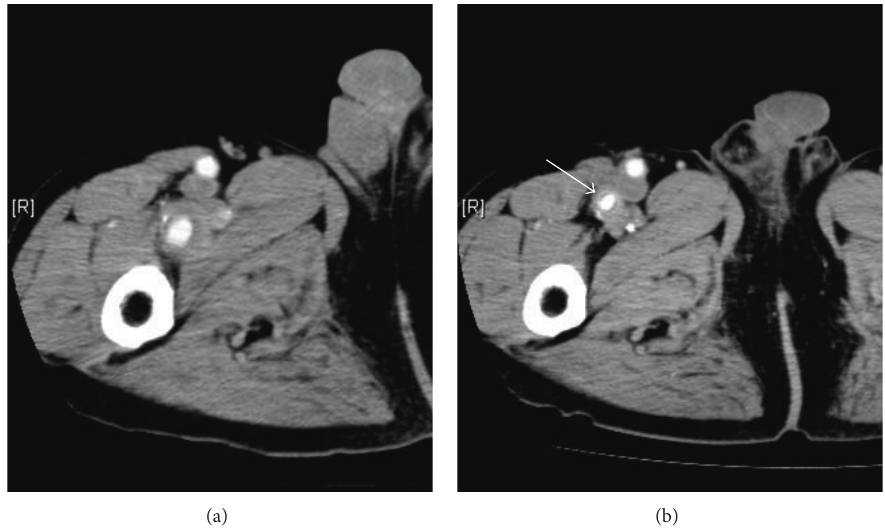
Figure 2: (a) Preoperative computed tomography exhibited a 22 mm right profunda femoris artery aneurysm with an intraluminal thrombus. (b) Postoperative computed tomography revealed a patent replaced prosthetic graft (white arrow). Table 2: Surgical procedures and intra- and postoperative findings.